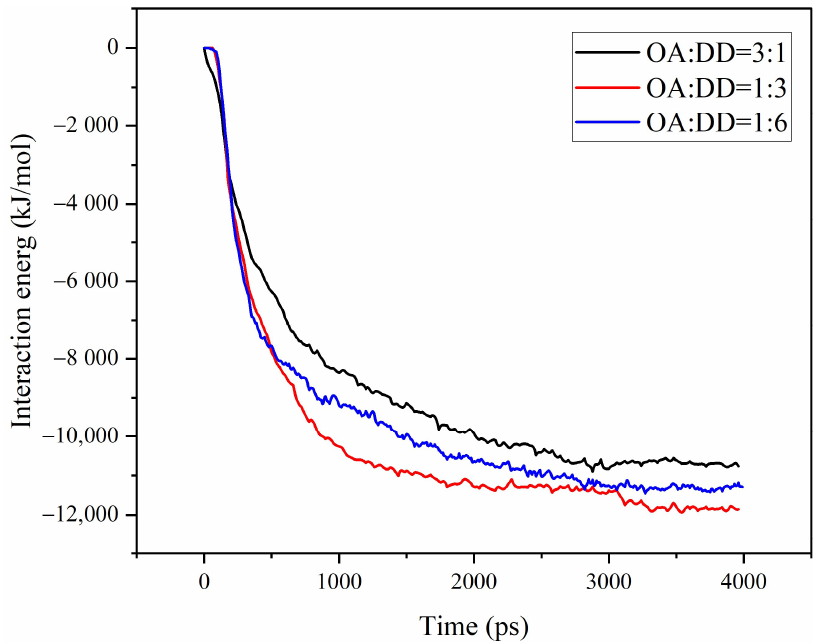
Figure 10. The change of interaction energy between collectors and LRC with time. The interaction energy between collectors and both water and the LRC model after equilibrium was subsequently calculated. The results are shown in Table 3. The larger the negative value, the greater the interaction energy. For an OA:DD ratio of 1:3, the interaction energy between collectors and LRC is the largest and is greater than that between the collector and water, resulting in optimal spreading. Table 3. The interaction energy between collectors and water and between collectors and the LRC model after